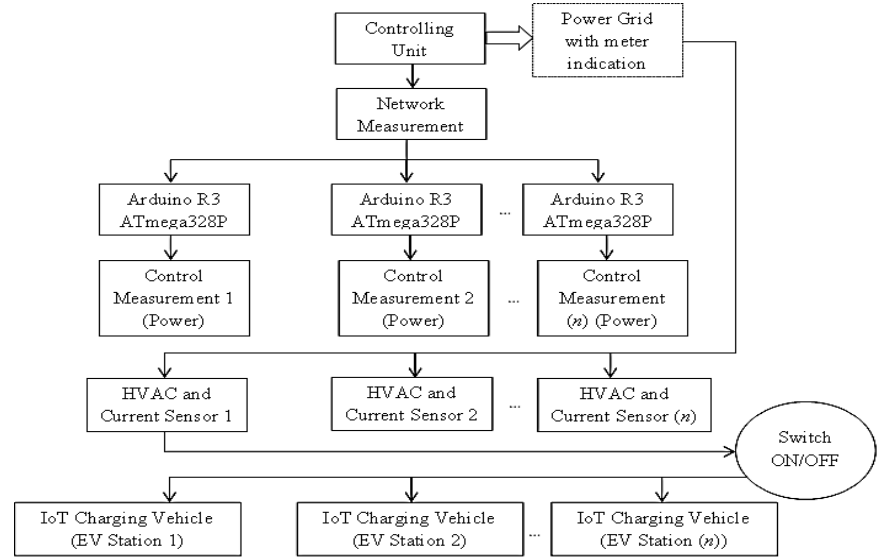
Figure 2. System architecture and wiring connection of proposed method. Table 2. Data source of